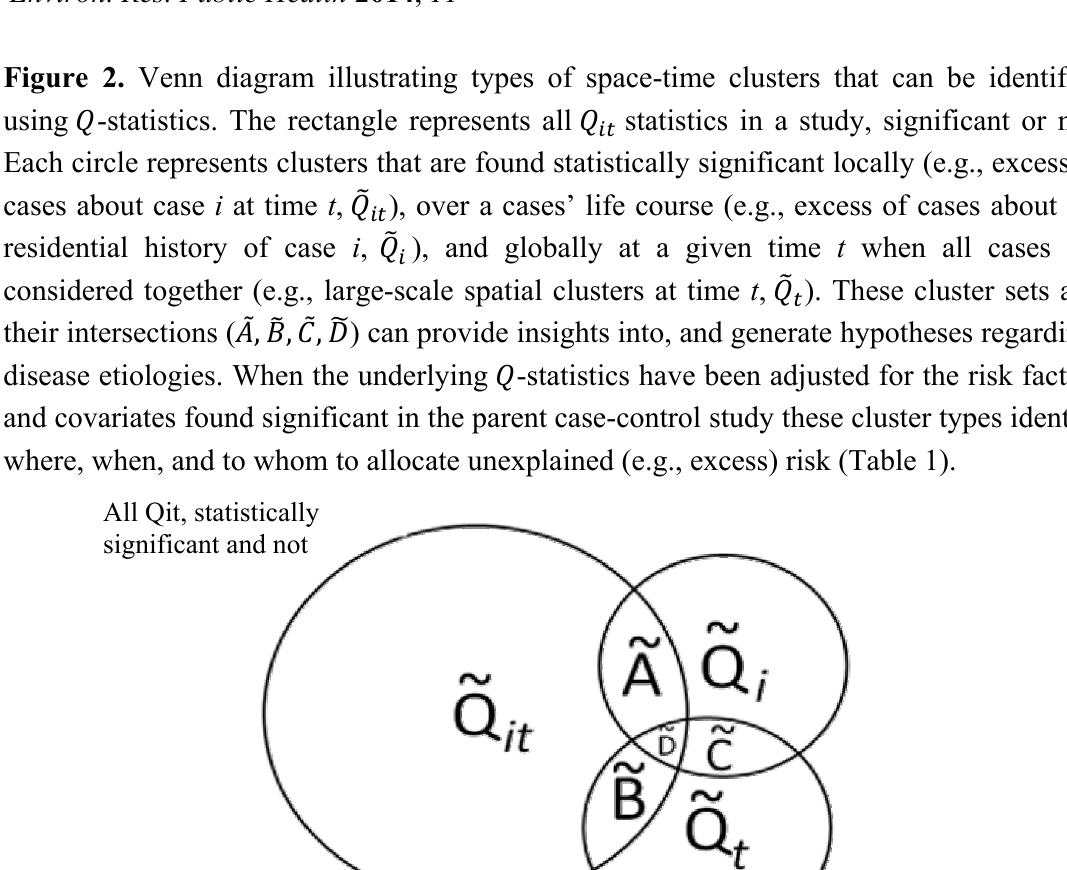
Figure 2. Venn diagram illustrating types of space-time clusters that can be identified using (cid:1843) -statistics. The rectangle represents all (cid:1843) statistics in a study, significant or not. (cid:3036)(cid:3047) Each circle represents clusters that are found statistically significant locally (e.g., excess of cases about case i at time t , (cid:1843)(cid:3560) ), over a cases’ life course (e.g., excess of cases about the (cid:3036)(cid:3047)